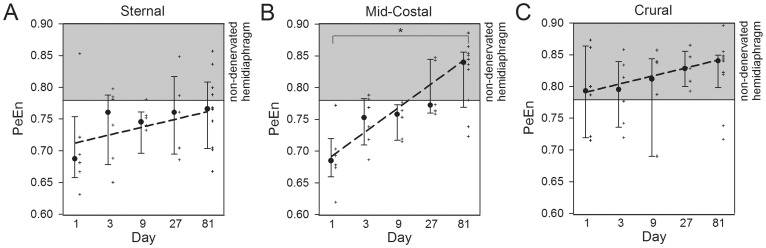
Median, interquartile ranges, values (+) and quantile regression (dashed line) of normalized permutation entropy (PeEn) values in the sternal (A), mid-costal (B) and crural (C) area 1–81 days after phrenicotomy such as in the non-denervated side (grey area: minimum and maximum).*: Significant increase of PeEn from day 1 to day 81 (quantile regression, threshold p<0.05).